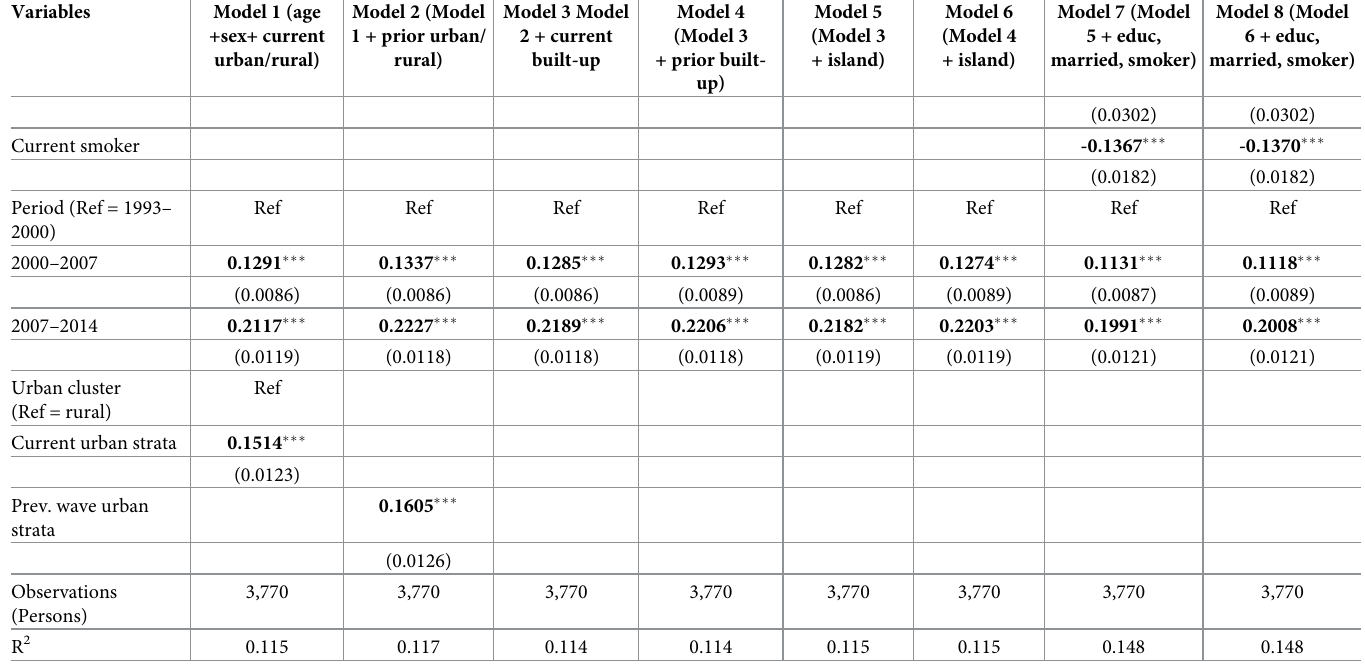
current (or lagged) built-up measures (Models 3 & 4). Evaluated at the average change in the proportion urban (+15.1 percentage points, based on Table 1) observed over the entire 21-year survey period, Model 1, suggests that the trend in urbanization as captured by the urban-rural dummy added 0.19 BMI points. Using our physical built-up measure, Model 3 predicts that the 6-percentage point average increase in built-up that occurred between 1993 and 2014 (see Table 1) translates into a BMI increase of 0.13 points (both calculations are based on models that adjust for age and